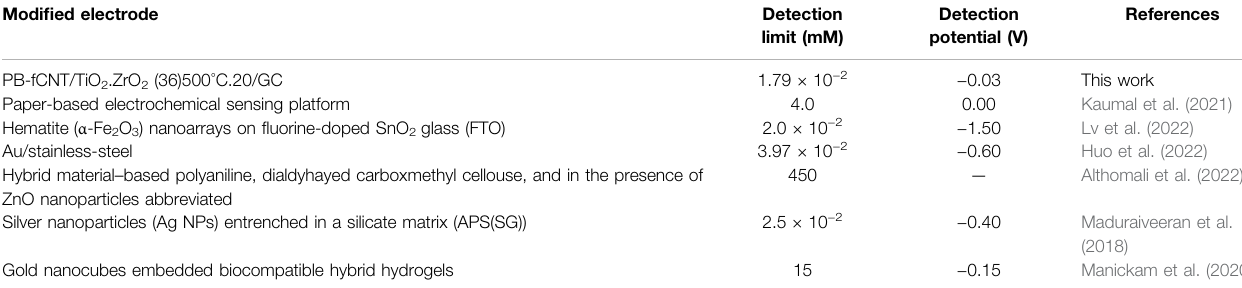
TABLE 6 | Comparison of the results obtained at modi fi ed electrodes with other electrodes reported in the literature. Modi fi ed